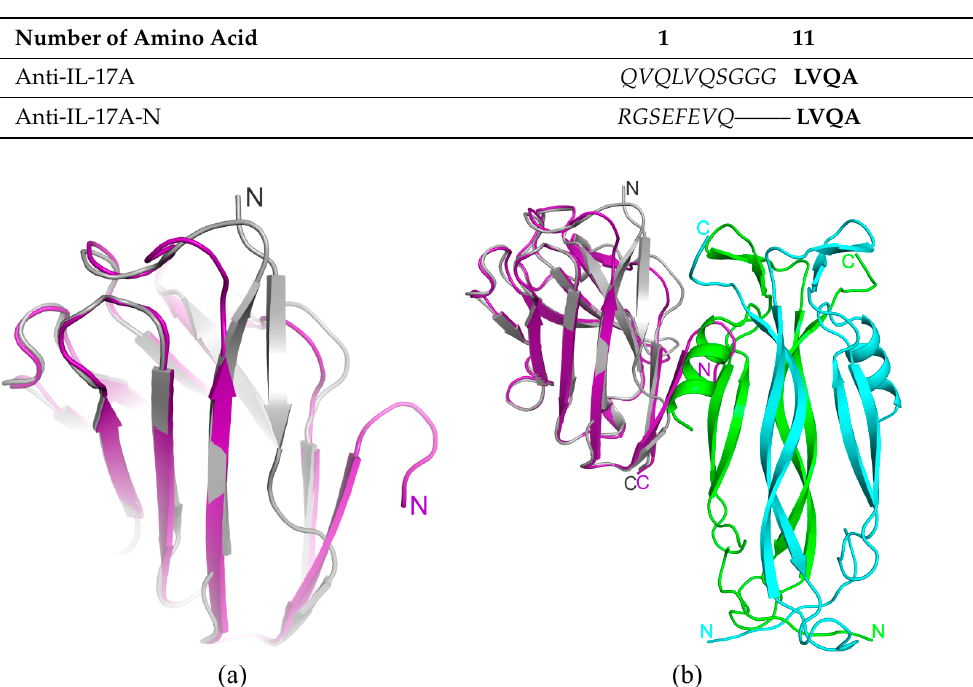
Figure 4. The surfaces show the IL-17A monomer (green) associated with the anti-IL-17A-76 (grey) in the asymmetric part of the cell. Ribbon models show the anti-IL-17A-76 (orange) and the second IL-17A monomer (blue). The IL-17A monomer and the anti-IL-17A-76 in contact with it are outlined. Table 3. Anti-IL-17A and anti-IL-17A-N amino acid sequence alignment in the N-terminal region. Amino acids of the altered region are shown in italic, matching amino acids are in bold.